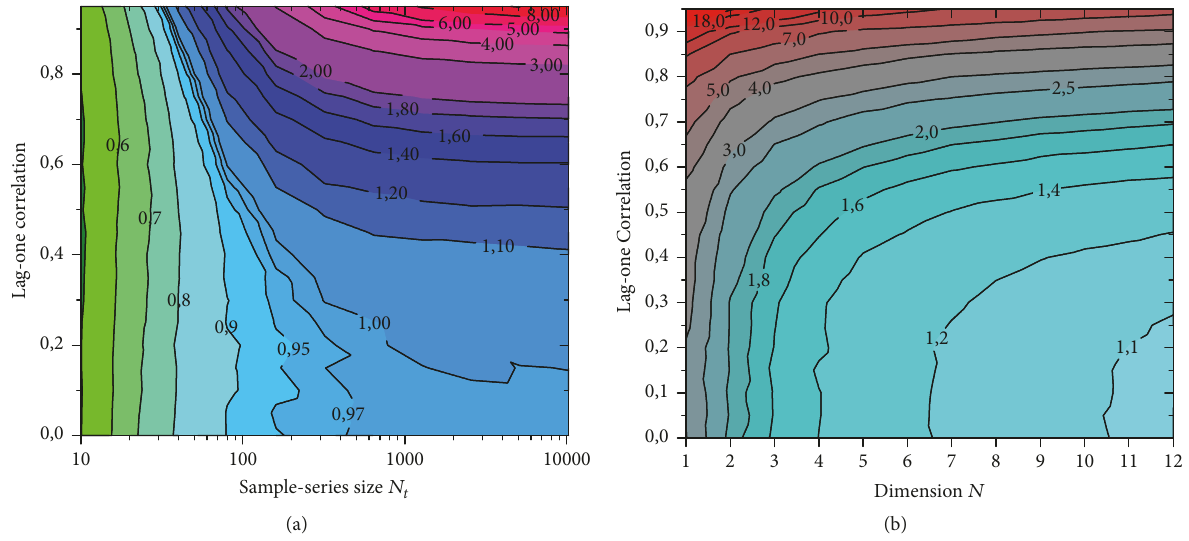
= 0.95 , for the confidence level 𝑝 Ed - 𝑃 sig sig